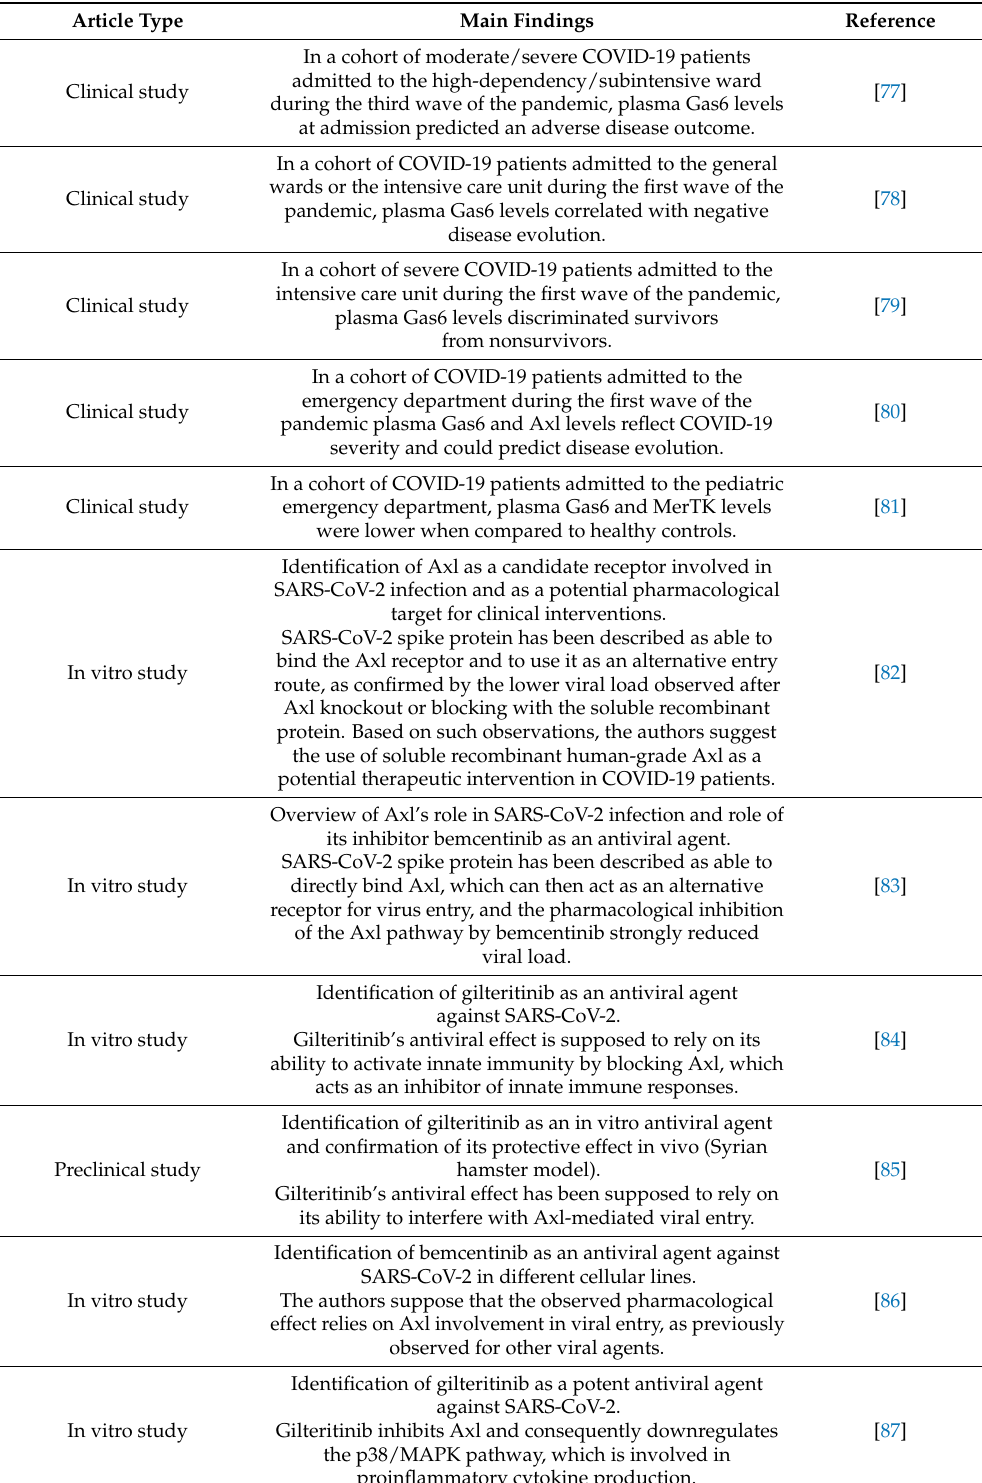
Table 1. Summary of the most relevant literature (in vitro and clinical studies, clinical trials, and case reports) regarding Gas6 and TAM receptors involvement in SARS-CoV-2 infection and COVID-19 progression and